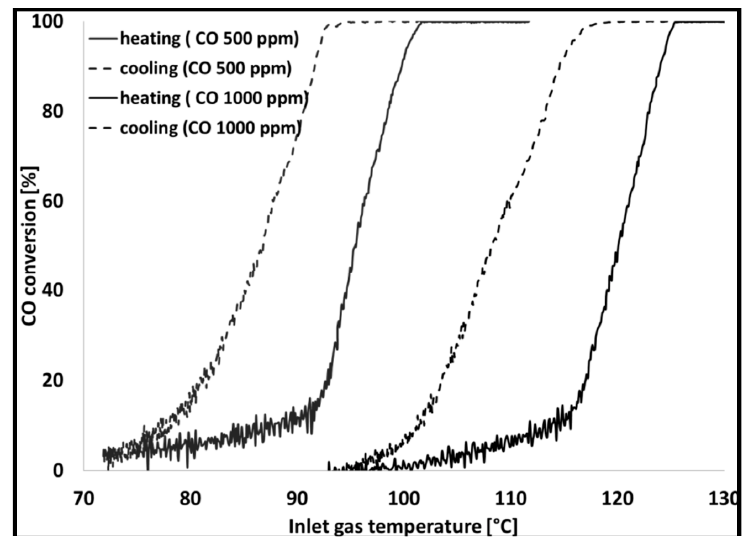
Figure 3. Temperature ‐ programmed CO oxidation with the following inlet conditions: 1000 ppm or 500 ppm CO, 10% H 2 O, 10% CO 2 , and 10% O 2 over a Pt/Al 2 O 3 monolith [77]. 500 ppm CO, 10% H 2 O, 10% CO 2 , and 10% O 2 over a Pt/Al 2 O 3 monolith